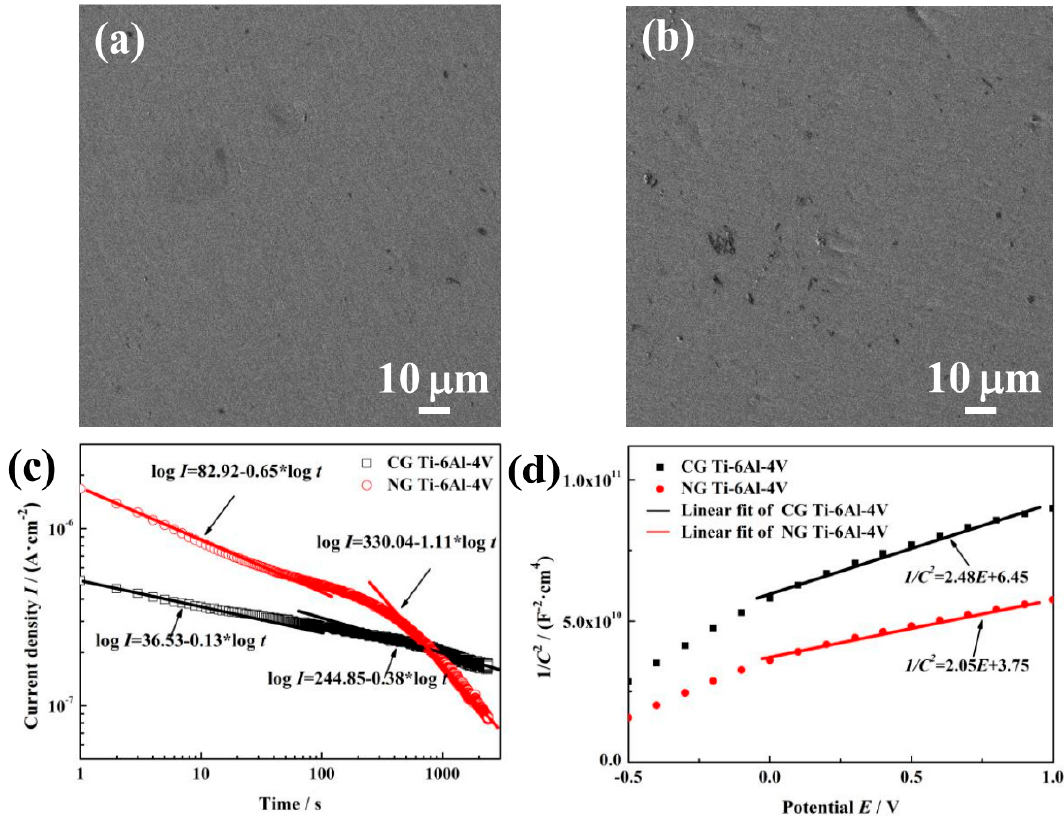
Figure 3. SEM surface micrographs of NG ( a ) and CG ( b ) samples after potentiodynamic polarization. Current vs. time curves ( c ) and Mott–Schottky curves ( d ) for NG and CG samples in SBF solutions at 37 °C.